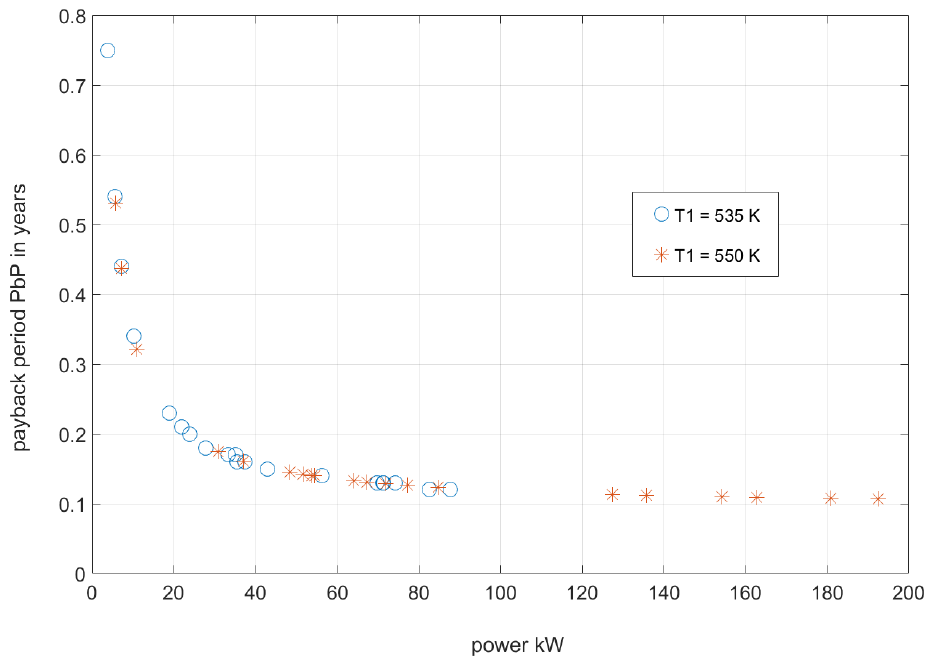
Figure 6. Analysis of available cases for two initial temperatures T 1 , PbP vs. generated power for a single expansion